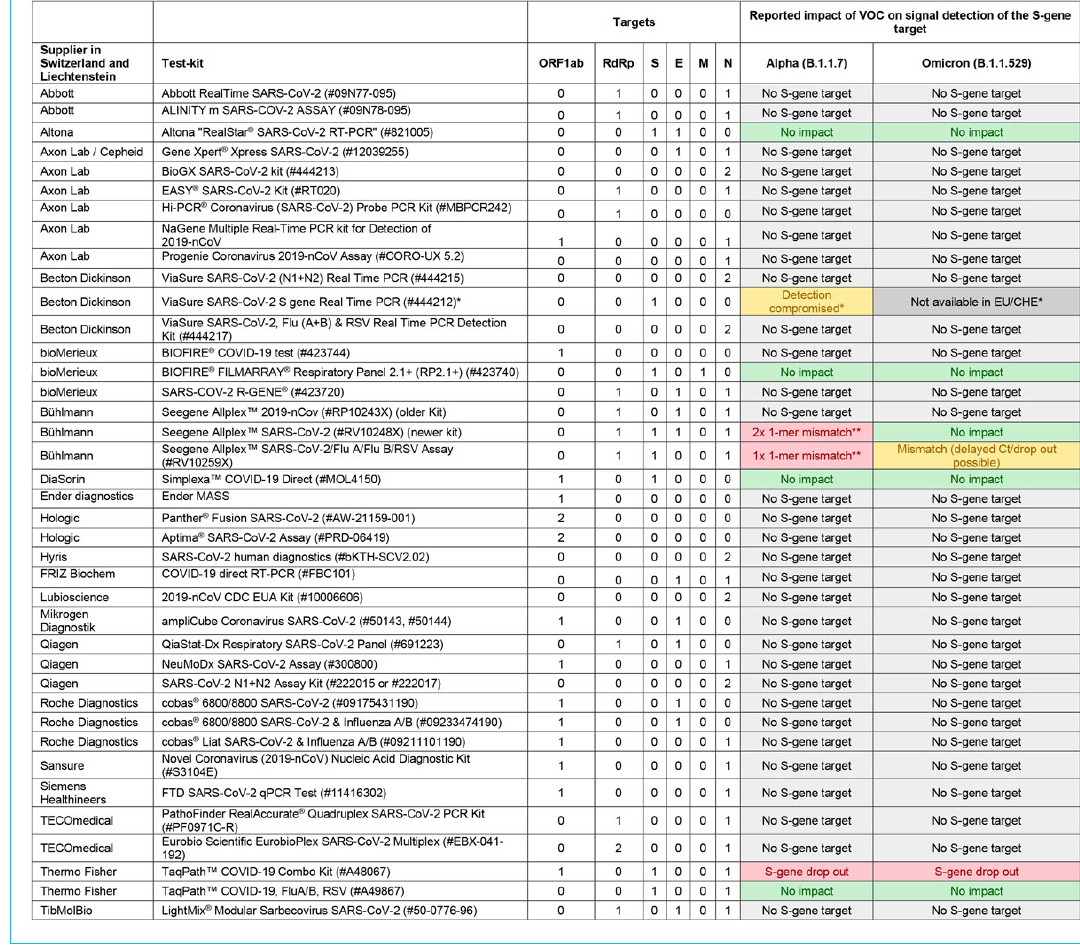
Figure 1: Selection of available PCR assays and the impacts on their performance of the Alpha and Omicron variants. * PCR-Kit no longer available on the Swiss market. ** Mismatch not detectable because both the S gene and the RdRp gene targets are detected using the same fluorescence